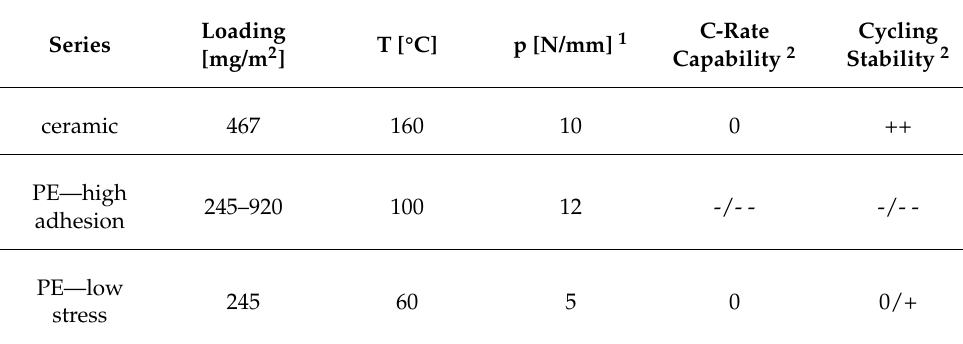
Table 2. Overview on electrochemical effects detected in full cell